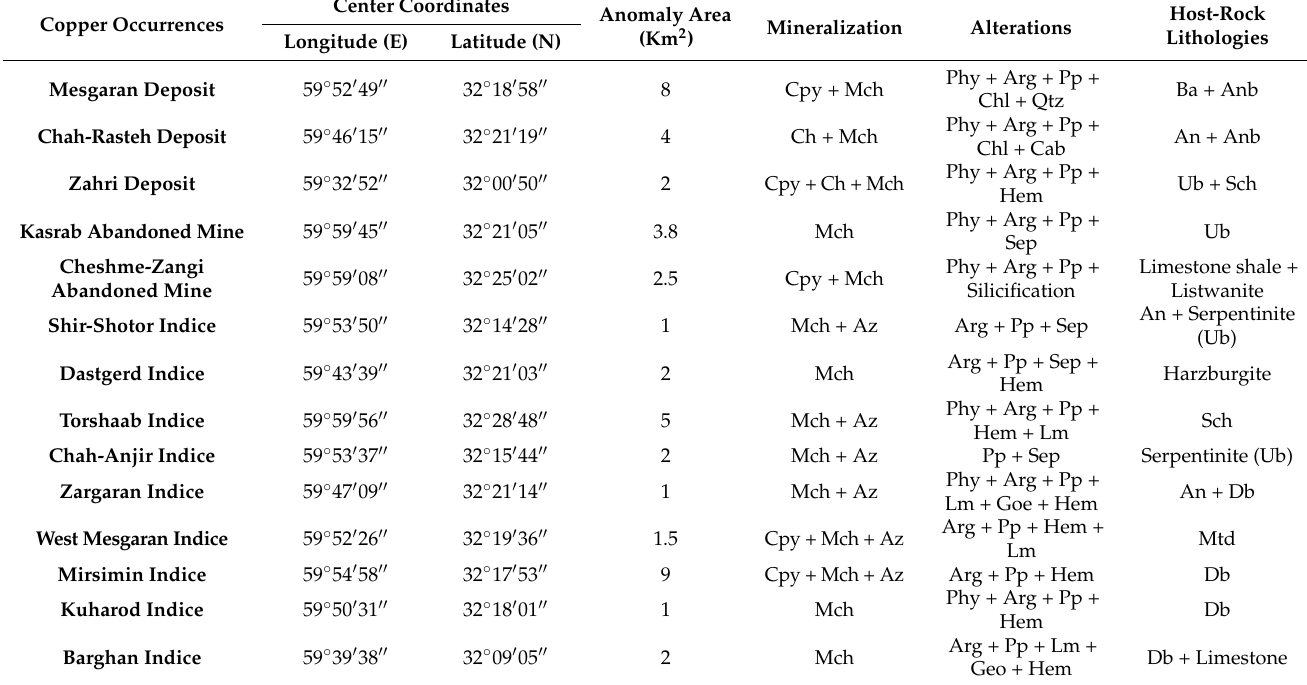
Table 1. Copper mineralization, host-rock lithologies and alteration zones in Sahlabad mining area [31]. Abbreviations: Cpy = Chalcopyrite, Py = Pyrite, Mch = Malachite, Ch = Chalcocite, Az = Azorite, Ba = Basalt, Phy = Phyllic, An = Andesite, Sch = Schist, Mtd = Metadiabase, Chl = Chlorite Alteration, Db = Diabase, Anb = Andesite-Basalt, Qtz = Quartz Alteration, Cab = Carbonate Alteration, Pp = Propylitic Alteration, Arg = Argillic Alteration, Ub = Ultraba- sic, Alteration, Sep = Serpentine Alteration, Hem = Hematite Alteration, Lm = Limonite Alteration, Goe = Goethite